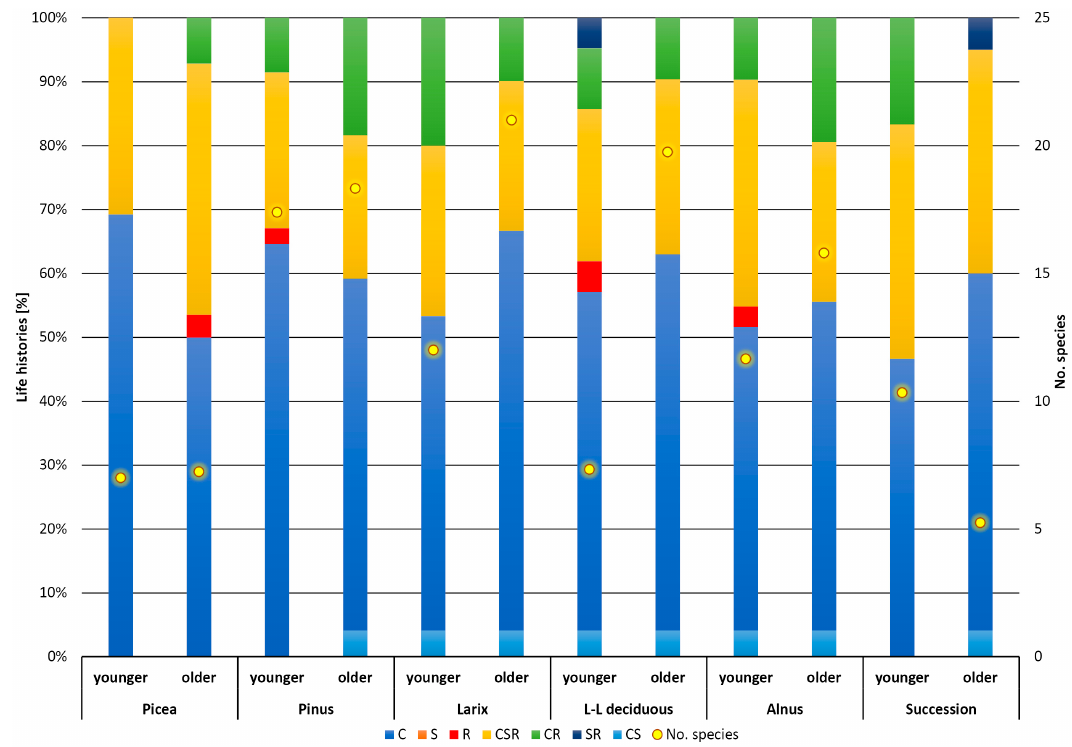
Figure 2. Life histories—distribution of functional groups in forest type and different ages. C—competitors, S—stress strategy, R—ruderal strategy, and their combinations.